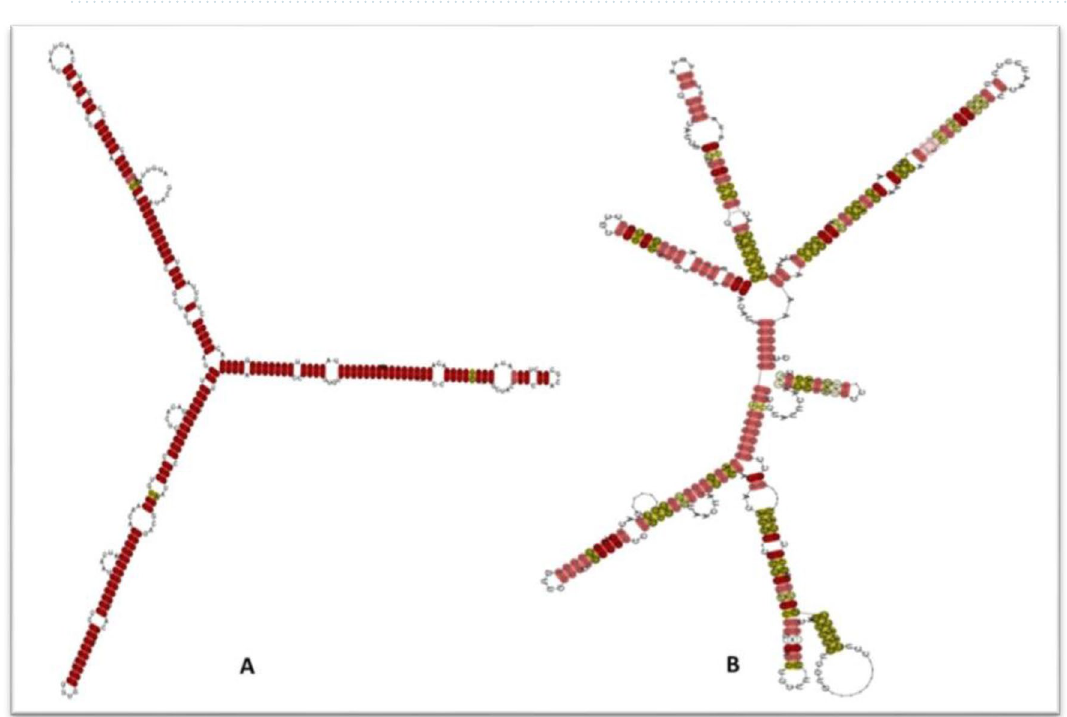
Figure 5. ( A ) Structural classification of the conserved consensus gL mRNA local structures belonging to the clinical group with HCMV induced end organ retinitis (HR). ( B ) Structural classification of the conserved consensus gL mRNA local structure belonging to the clinical group with HCMV induced end organ gastroenteritis